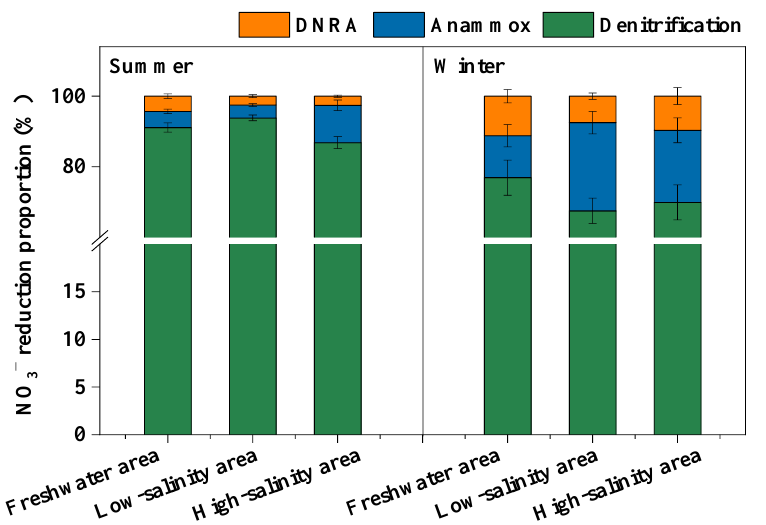
Figure 4. The proportions of denitrification, anammox and DNRA to gross NO 3 − reduction in the freshwater, low-salinity and high-salinity area.